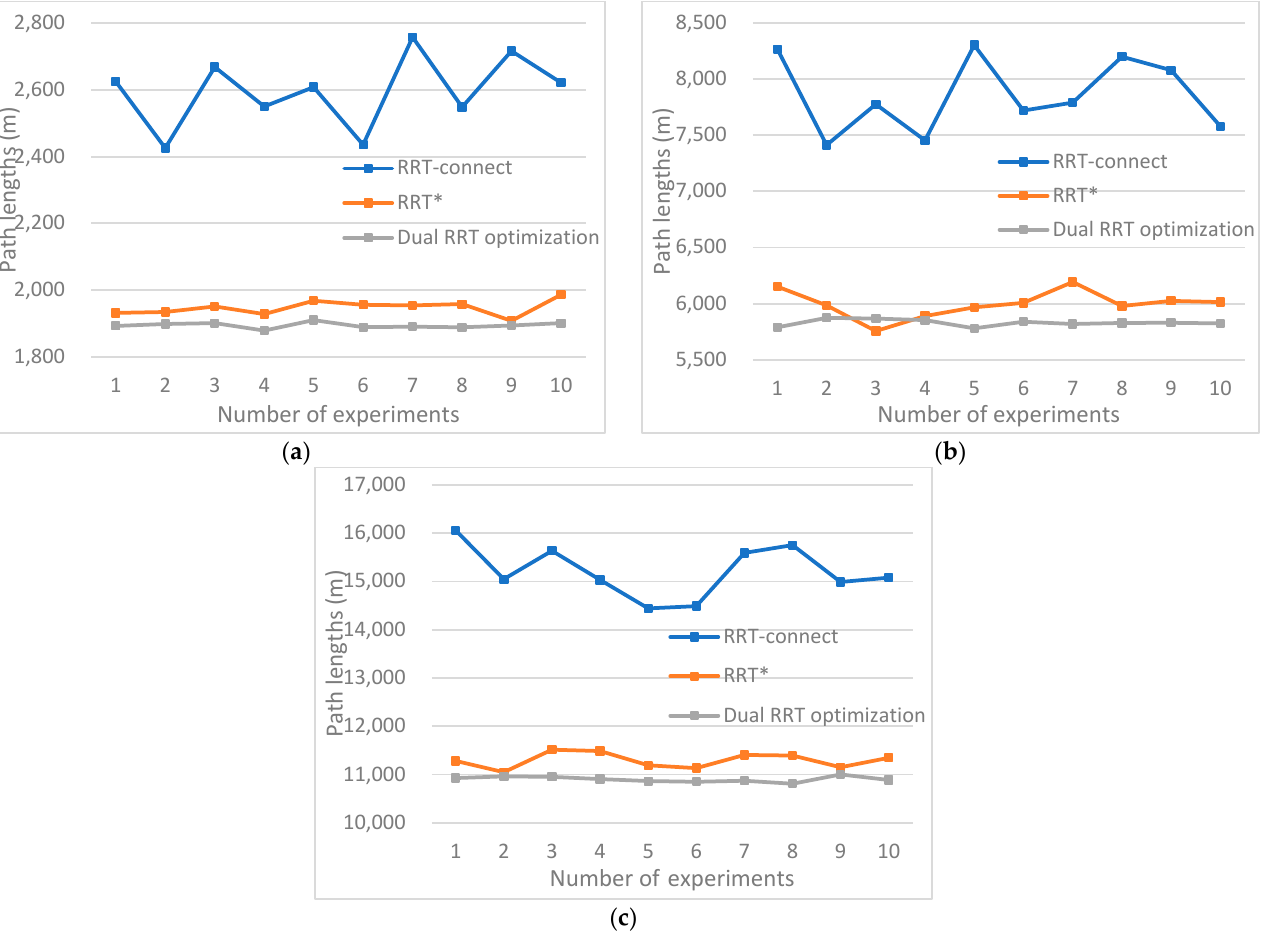
Figure 14. Changes in total length of path results for each algorithm run ten times. ( a – c ) represent total length changes for 5, 15, and 30 vehicles, respectively.